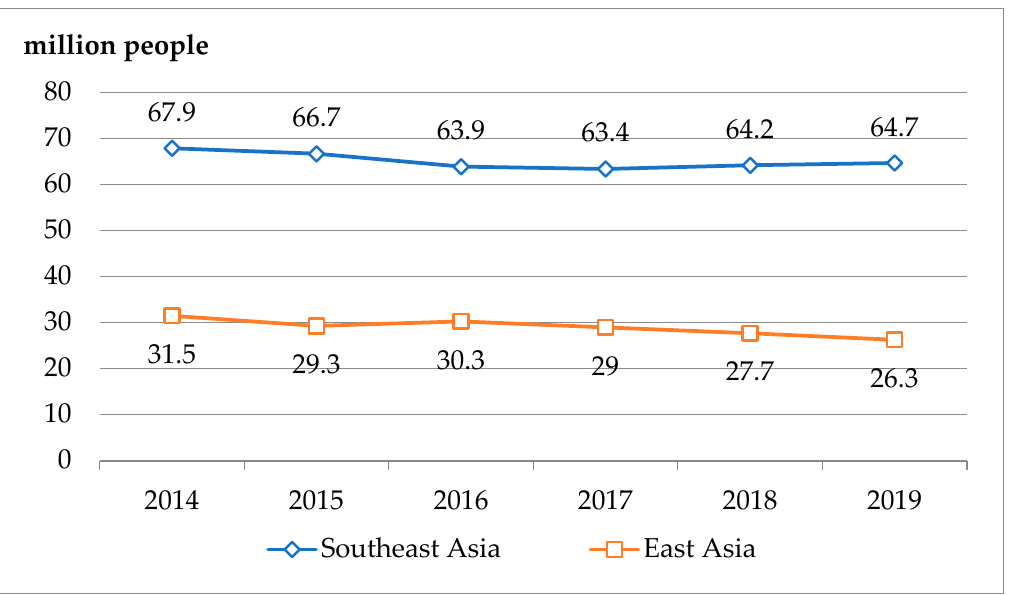
Figure 8. Number of undernourished people in East and Southeast Asia (Source: data retrieved from [4]).